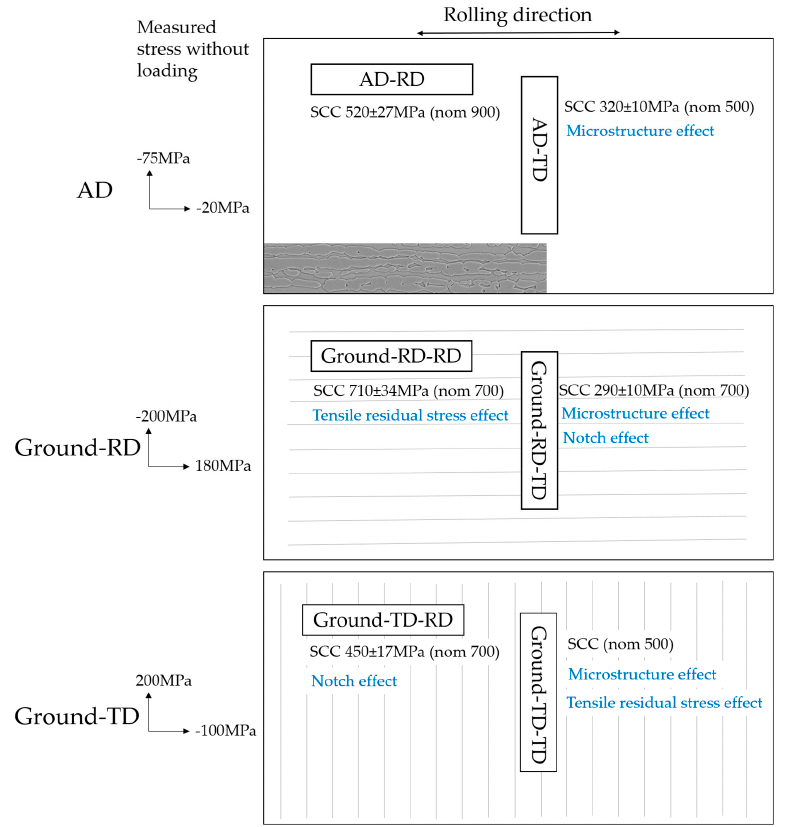
Figure 12. Summary of measured residual stresses and threshold stresses for macrocracking, illustrating the major factors affecting the SCC susceptibility. Positive values denote tensile stresses and negative compressive stresses.